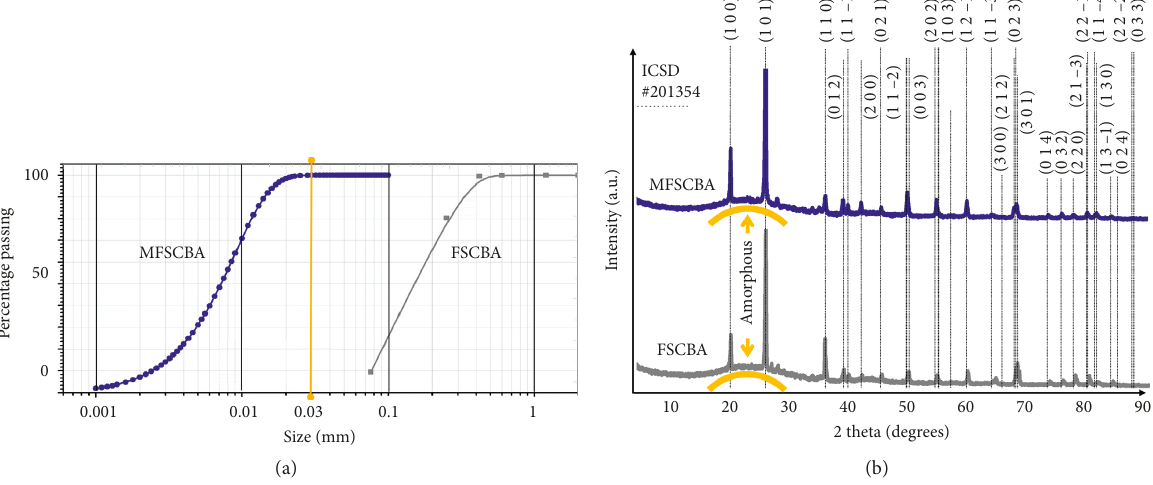
Figure 3: Granulometric curves of fly sugarcane bagasse ash samples and X-ray diffraction (DRX) patterns. (a) Granulometric curves of MFSCBA and FSCBA samples and (b) DRX patterns of MFSCBA and FSCBA